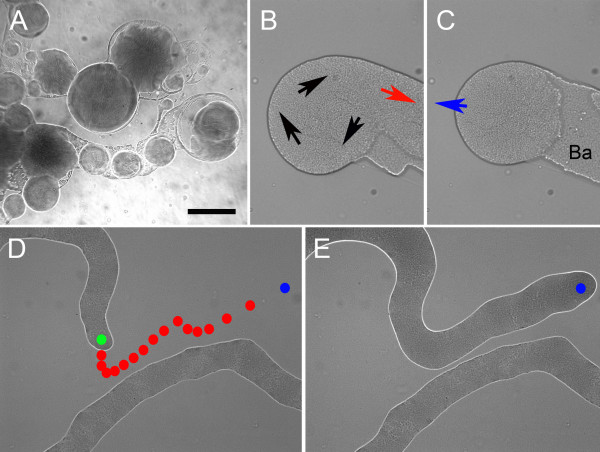
Dynamic imaging of swarming by light microscopy. Stills from movies of swarming motile masses of P. vortex. A. Rotating colonies spinning out from a central mass on MH (1.5% w/v) agar. Material between rotating colonies (all are in motion) is highly reflective basal material with a small number of cells. B. Start of detachment of rotating colony from the edge of a swarming culture on MH (1.5% w/v) agar. Black arrows indicate direction of rotation, with the bulk of cells withdrawing (red arrow) to leave colony isolated. C. As (B), 5 min later with further withdrawal of main mass of cells; a few minutes after this the spinning colony moved away in the direction of the blue arrow. Ba = reflective basal material. D. Moving mass of cells on MH (0.3 % w/v) agar; first image with the center of the tip shown as a green dot and the track of subsequent movement shown as the position of the tip one red dot every 20 s. The tip of a moving mass avoids a second moving strand of cells to which it is interconnected. E. From the same image stack as D but taken 10 min later with same (last) position shown in both (D) and (E) as a blue dot.